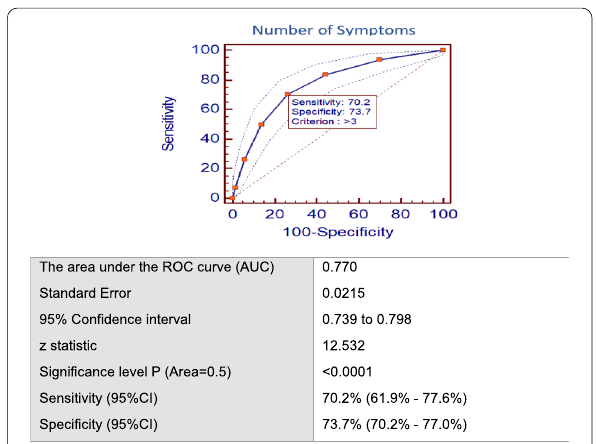
Fig. 2 ROC curve to determine the cutoff number of symptoms at which the cases became diagnosed ( n 149) among the = symptomatic cases ( n =